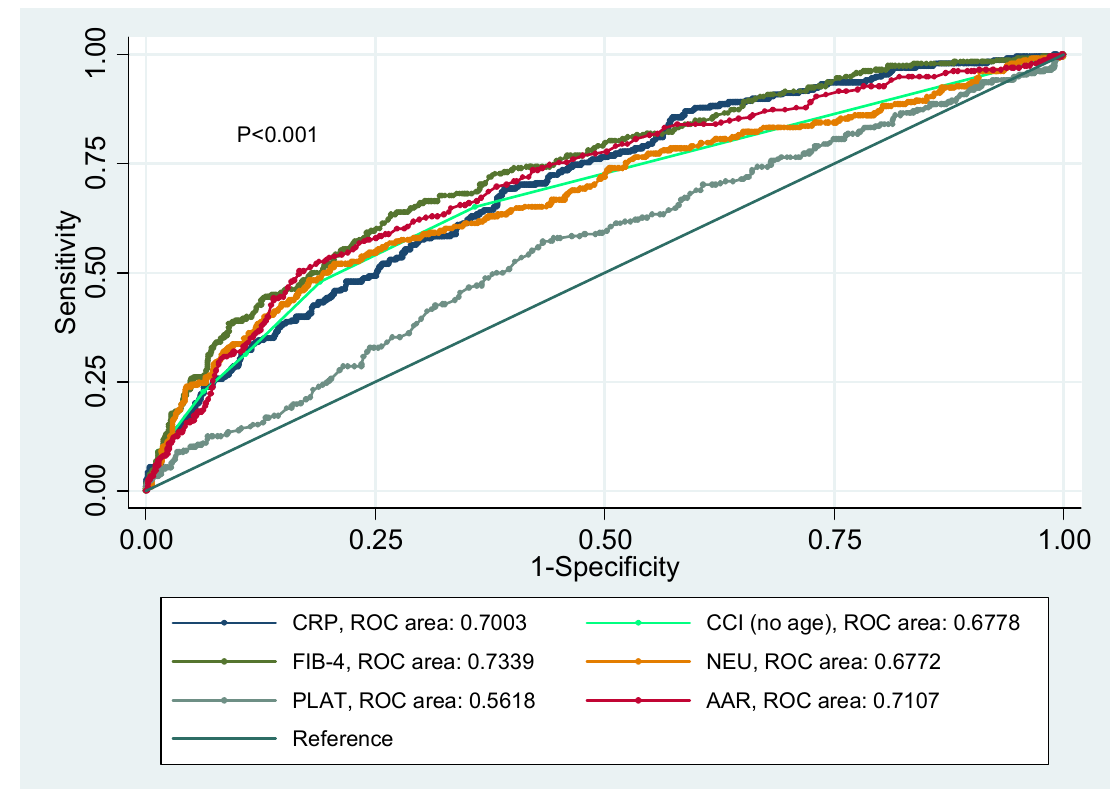
Figure 2. ROC curves showing the predictive value of CCI (no age), CRP, NEU, FIB-4, PLAT, and AAR concerning COVID-19 outcomes (ICU plus Death).